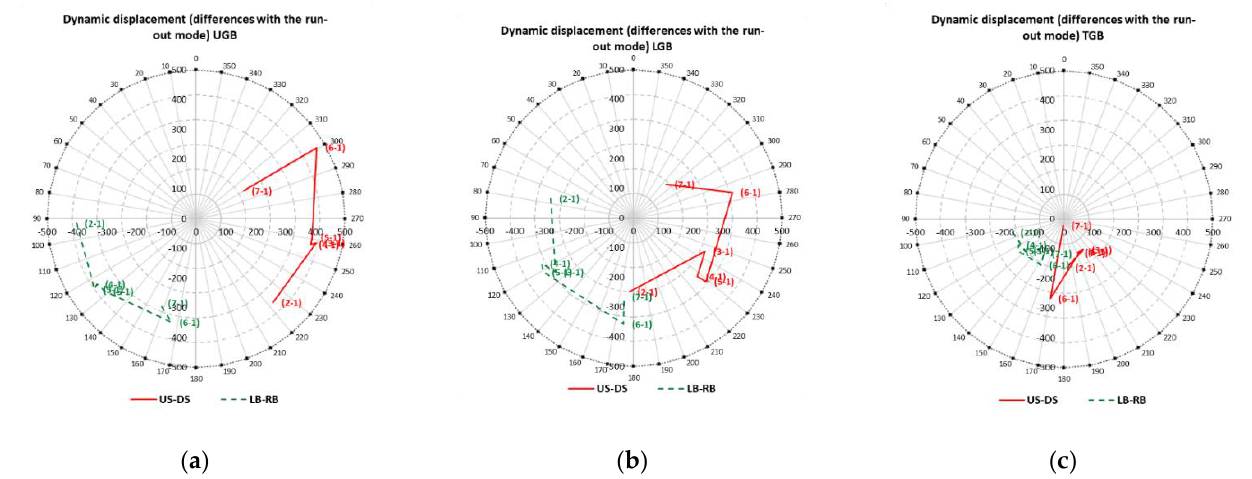
Figure 3. Vector diagrams of the dynamic shaft displacement 1st harmonic’s increment near guide